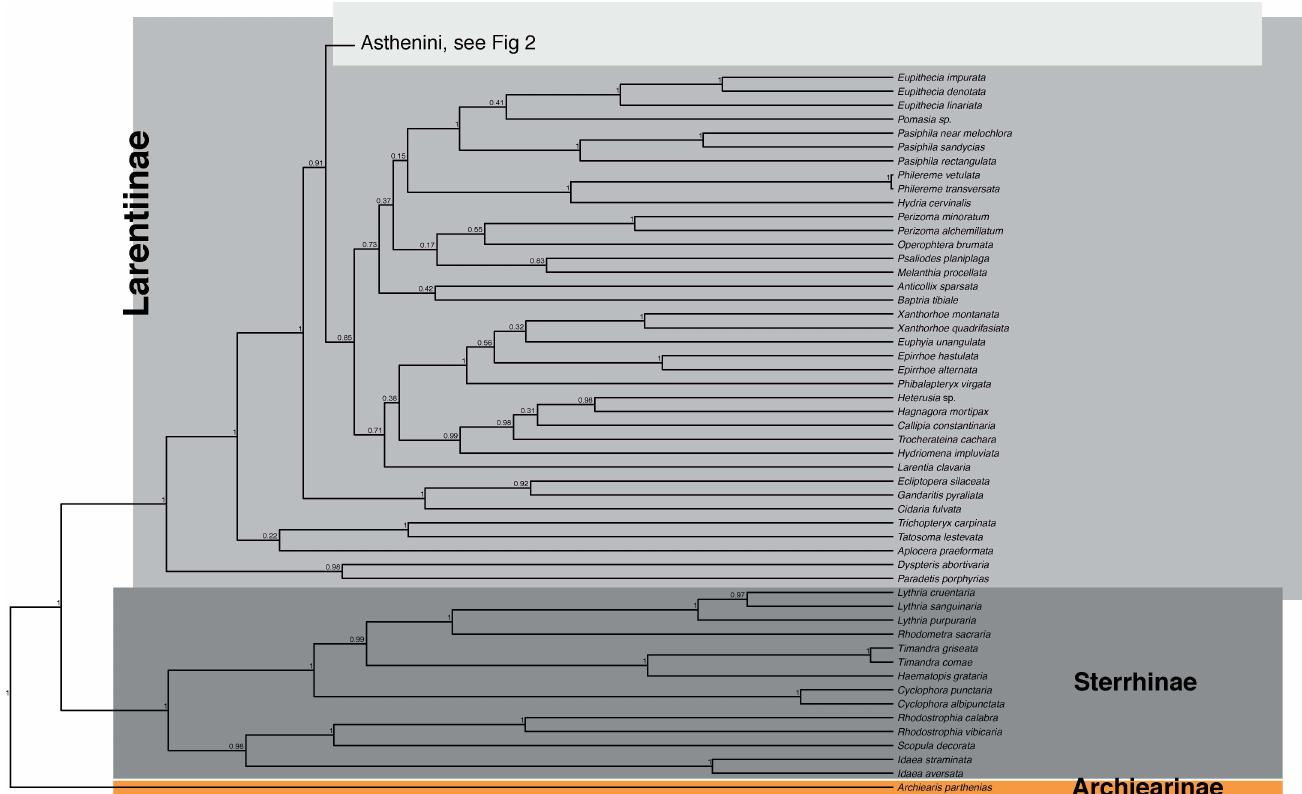
Fig 1. Phylogenetic tree obtained from BEAST. Part 1. Outgroup portion of the phylogenetic tree obtained from BEAST. Bayesian posterior probabilities are given at nodes.